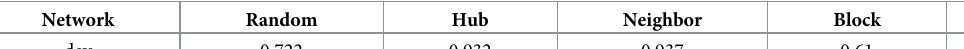
Table 3. Deviations from the exchangeable condition of six different network structures.